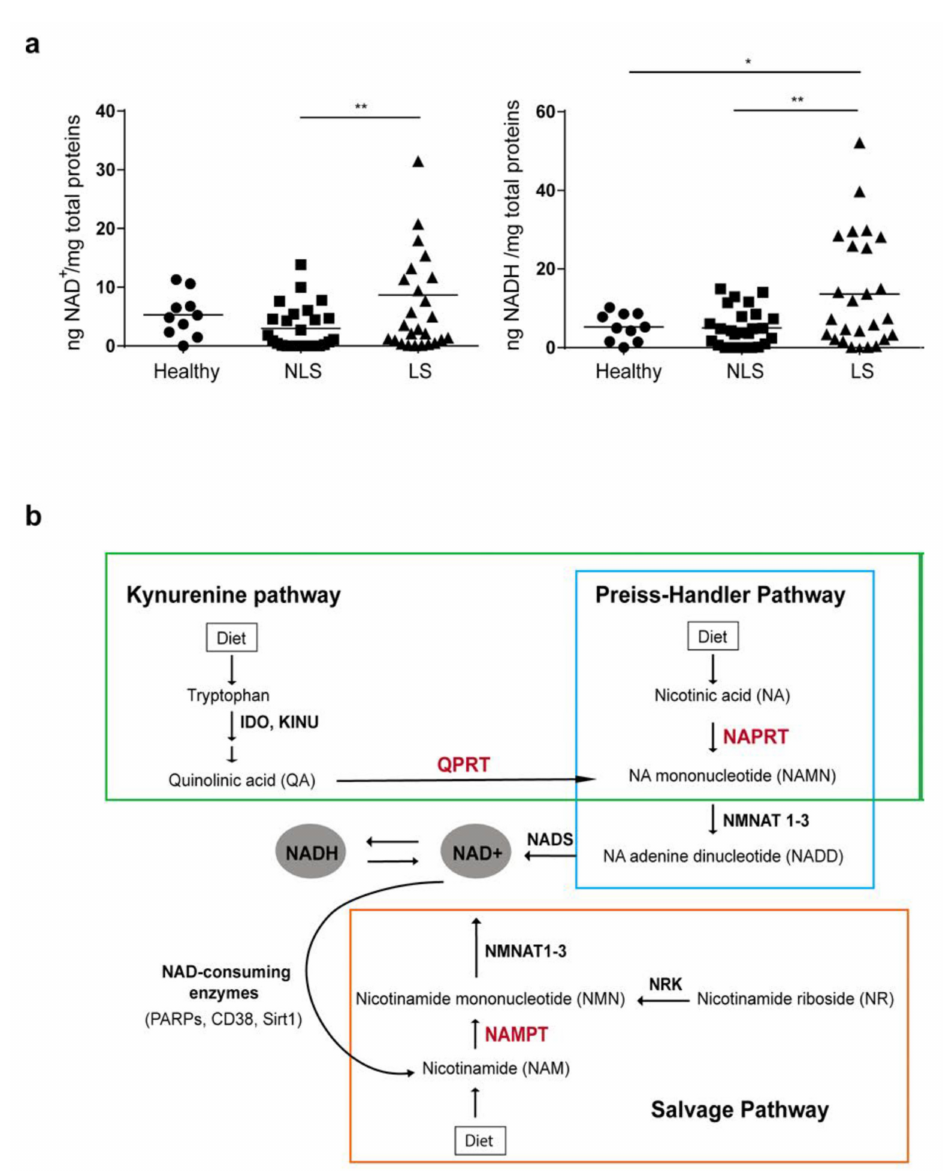
Figure 1. Intracellular NAD pool is higher in lesional (LS) skin of psoriasis patients than in uninvolved, non-lesional (NLS) skin. ( a ) NAD + and NADH levels were quantified by colorimetric assay in NLS and LS skin specimens of target plaques obtained from patients ( n = 25) affected by moderate-to-severe plaque psoriasis, as well as in healthy biopsies from donors ( n = 10). The results are shown as individual values (ng/mg total proteins) and mean. Statistical significance was assessed by Mann–Whitney U test. * p ≤ 0.05 and ** p ≤ 0.01. ( b ) Graphical representation of the NAD biosynthetic pathways. NAD can be synthetized de novo starting from tryptophan (KYNUrenine pathway, green rectangle), or through salvage routes from NAM or NR (salvage pathway, orange rectangle), or metabolizing NA in the Preiss–Handler pathway (light blue rectangle). The rate-limiting enzymes of each biosynthetic pathway are indicated in red, the other enzymes involved in the reactions in black. NAD synthetized from NAM via NAMPT is in turn used by NAD-consuming enzymes which release NAM, making it available for continuous NAD